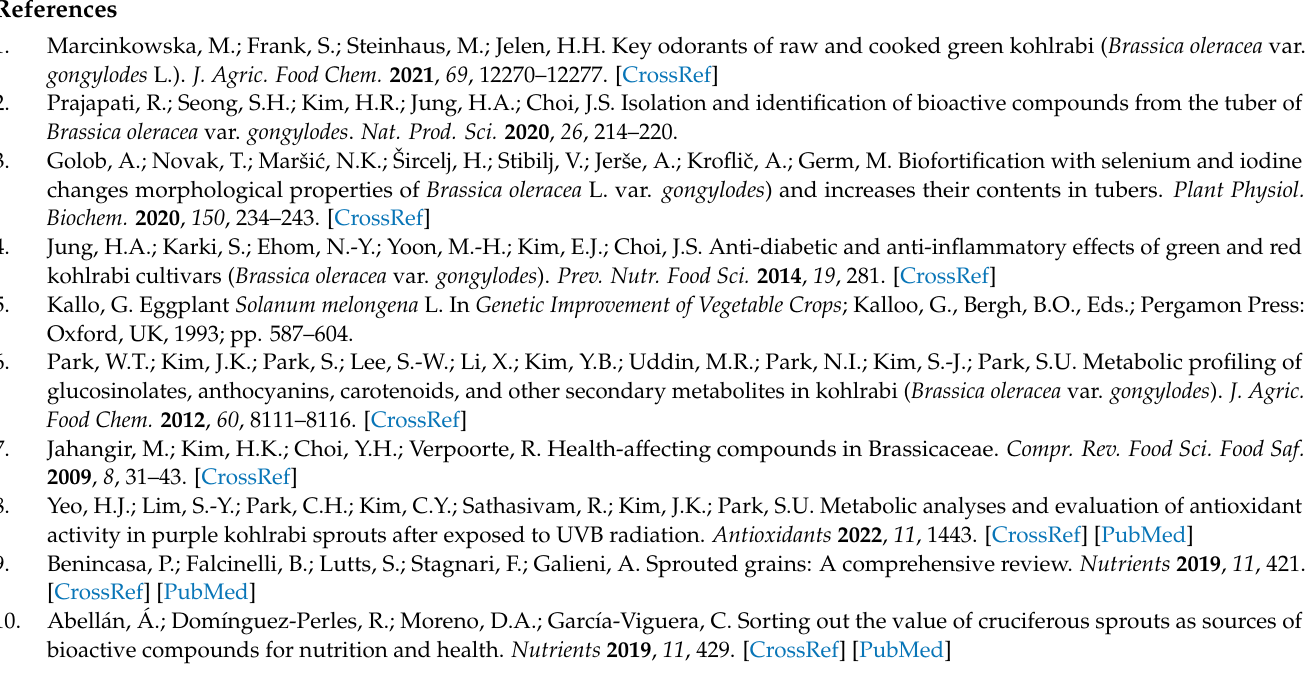
Table S1: Phenylpropanoid content ( µ g/g DW) in kohlrabi sprouts irradiated with different LED lights; Table S2: Glucosinolate content ( µ g/g DW) in kohlrabi sprouts irradiated with different LED lights; Table S3: Carotenoid content ( µ g/g dry weight) in kohlrabi sprouts irradiated with different LED lights; Table S4: Metabolic pathways where the identified metabolites are involved in kohlrabi sprouts irradiated with different LED lights; Table S5: Retention times (RTs), relative retention times (RRTs) and quantification ion data of hydrophilic compounds in